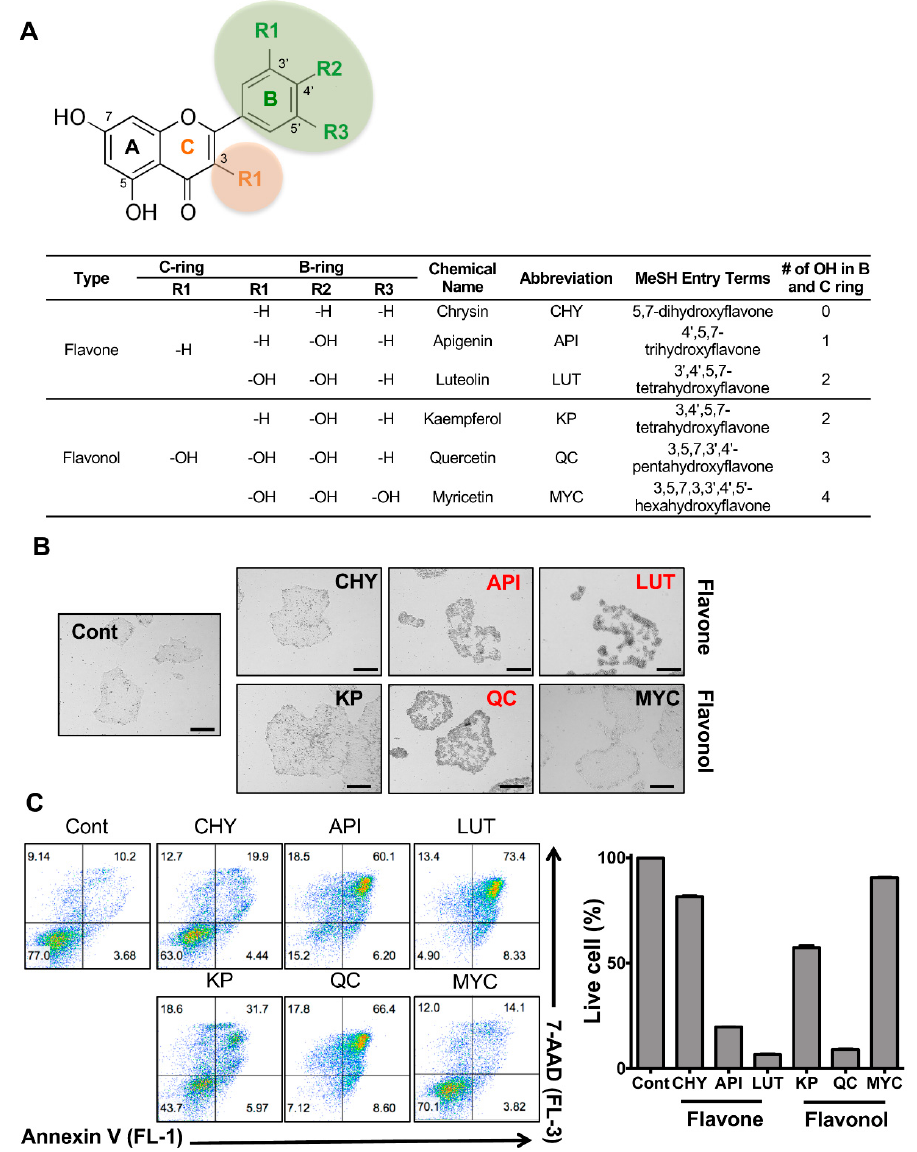
Figure 1. Stemotoxic screening of flavonoids. ( A ) Chemical structure of flavonoids (top) and table (bottom) used in this study ( B ) Microscope images of hESCs 24 h after treatment with 50 µ M of indicated flavonoids (scale bar = 200 µ m), Flavonoids inducing cell death were indicated in red. ( C ) Flow cytometry for Annexin V / 7-AAD assay (left) and graphical presentation of live cells (Annexin V and 7-AAD negative population, right) at 24 h after a 50 µ M treatment of indicated flavonoids ( n = 3).